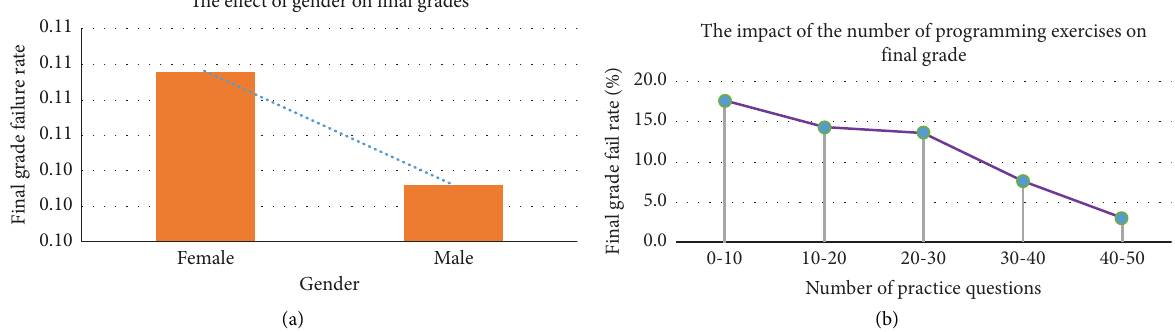
Figure 12: (a) Efect of gender on fnal grade and (b) efect of the number of practice questions on grade.